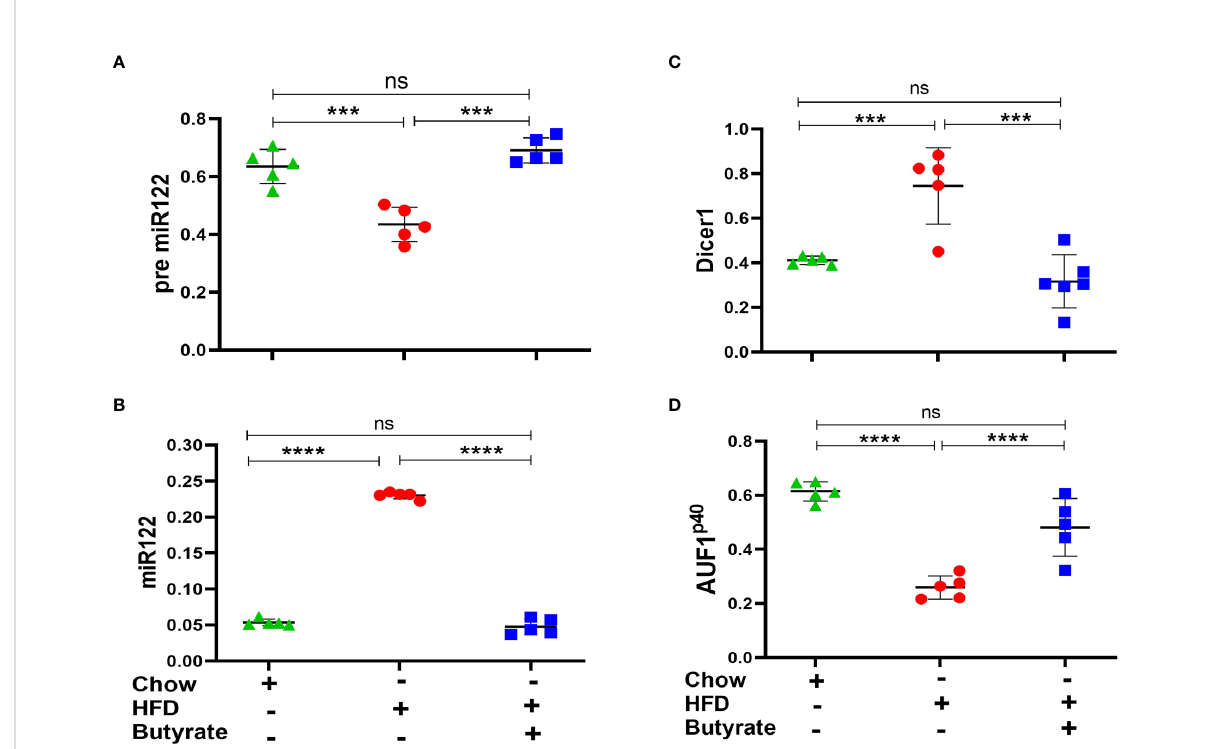
FIGURE 5 Hepatic miR122, Dicer1, and AUF1 p40 in chow mice, HFD mice, and HFD butyrate mice. Hepatic expression of pre-miR122 (A) , miR122 (B) , Dicer1 (C) , and AUF1 p40 (D) , in chow mice, HFD mice, and HFD butyrate mice by qPCR. N = 5/group; data are presented as mean ±SE. The experiment was repeated thrice. **** represents p < 0.0001, *** represents p < 0.001, and ns represents not signi fi